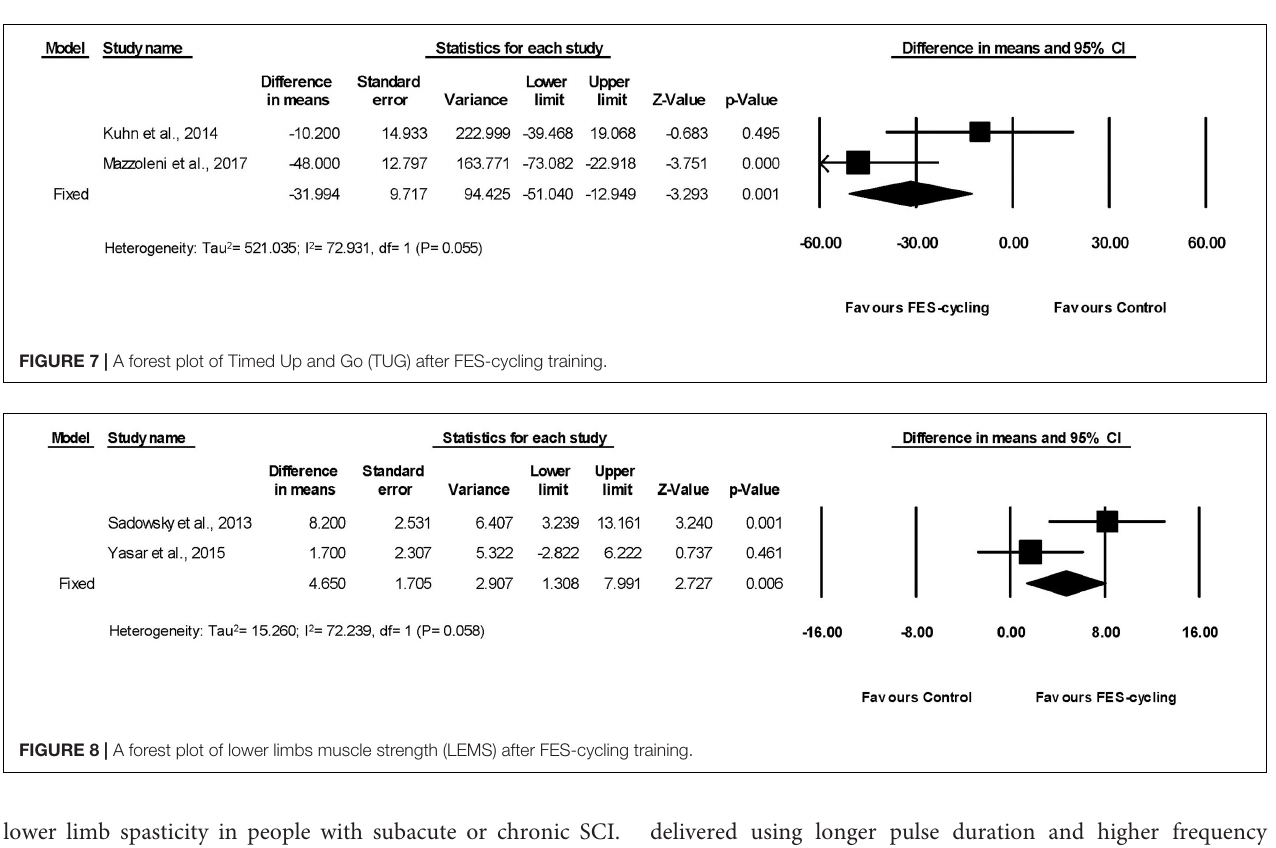
lower limb spasticity in people with subacute or chronic